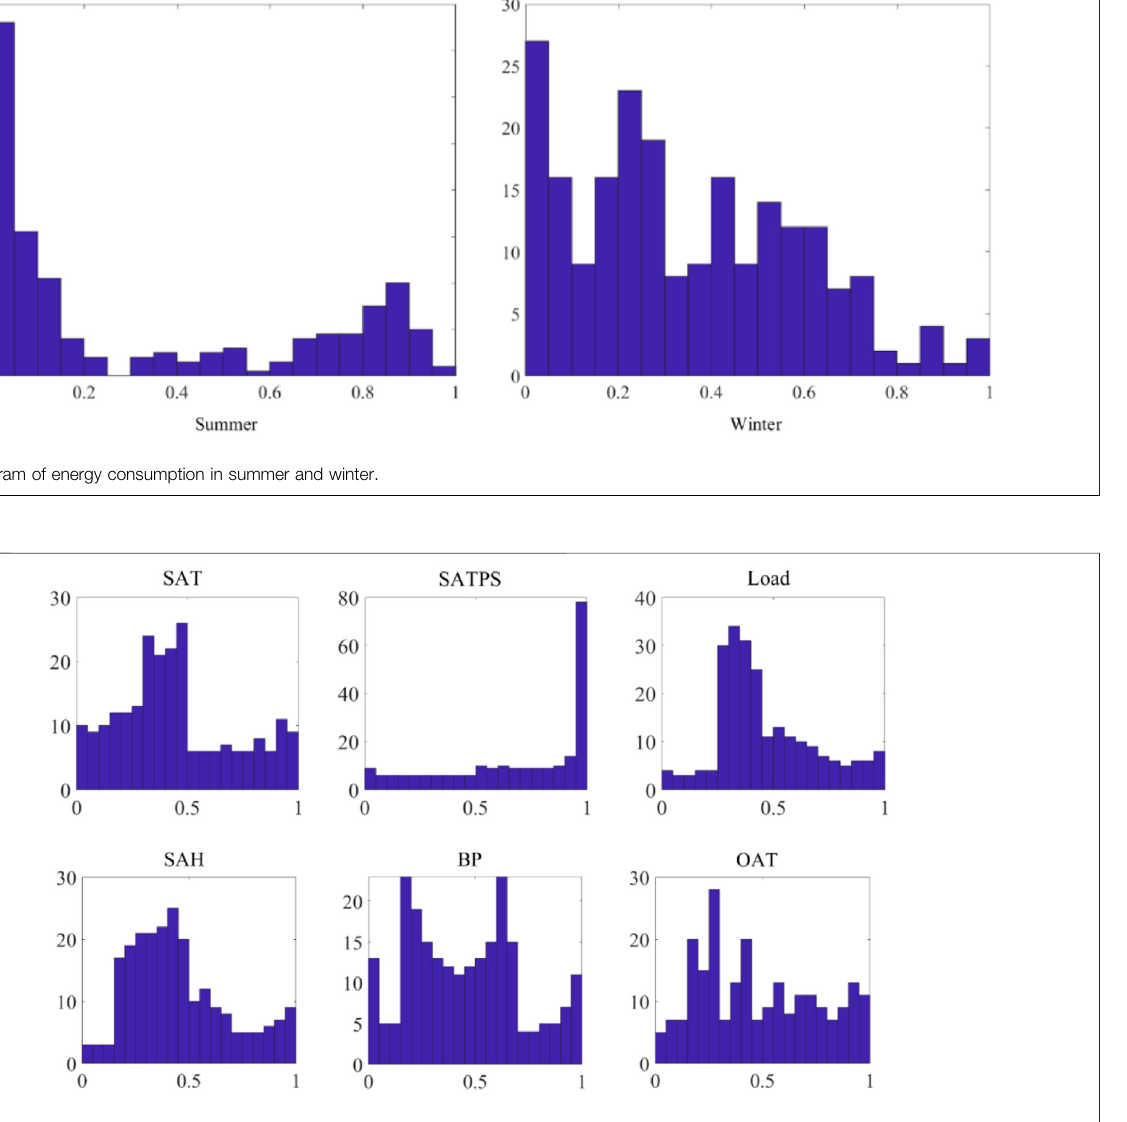
FIGURE 4 | Histogram of predictor